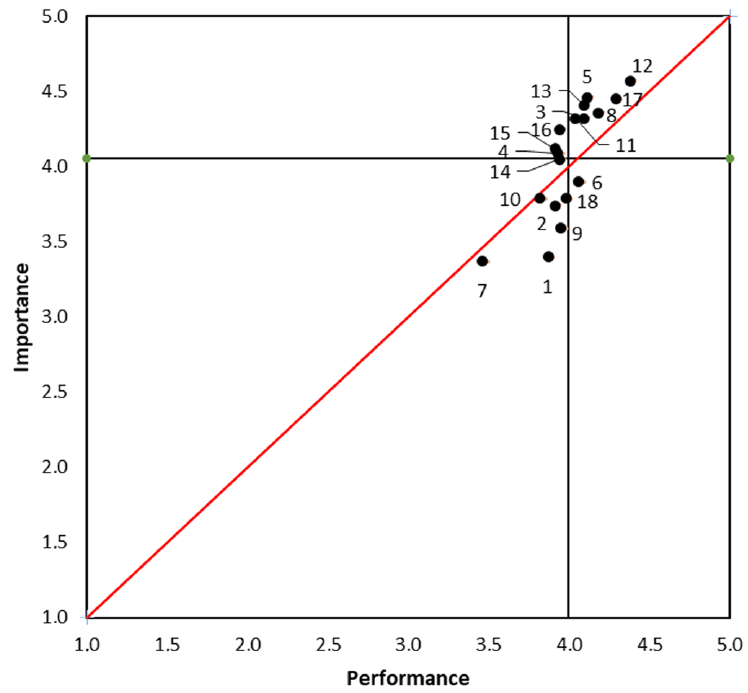
Figure 2. Obtained results as shown in the IPA Matrix.